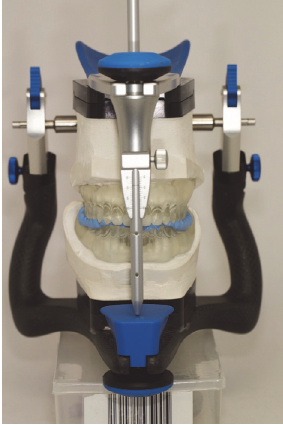
Figure 5: Record of the maxillomandibular relation.